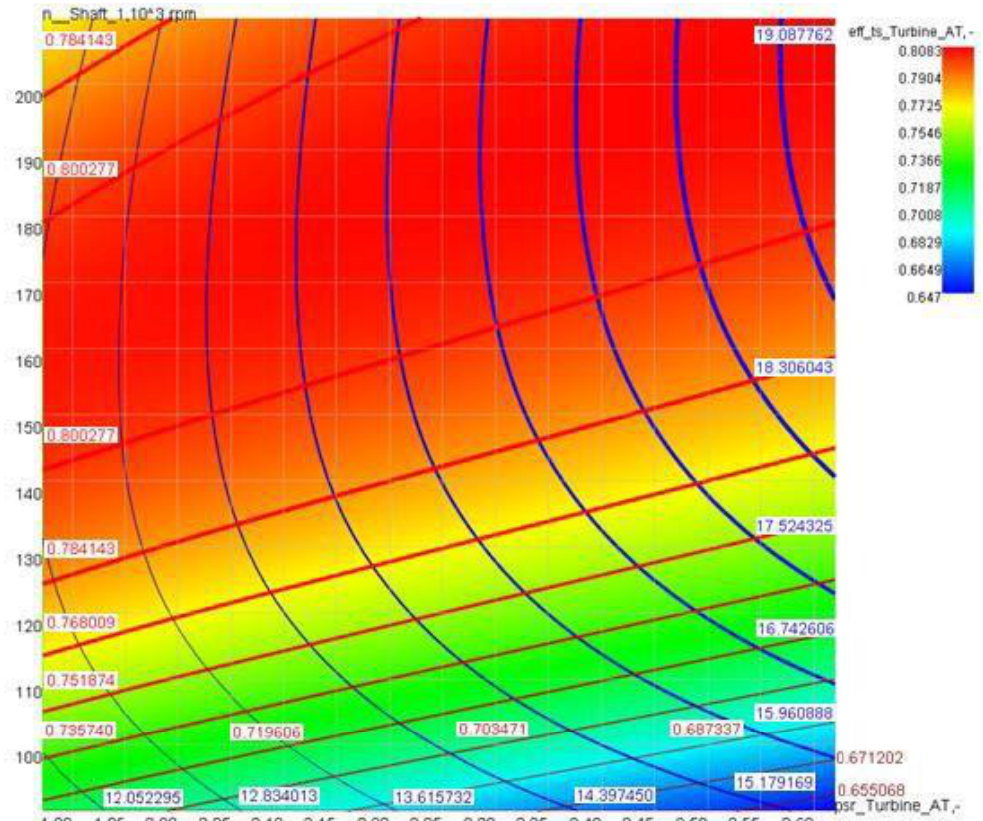
Figure 20. Prismatic Range 3 turbine map ( y -axis: shaft speed in rpm (1000 s); x -axis: turbine pressure ratio). The legend at the top right-hand side indicates the range of total-to-static turbine efficiency.